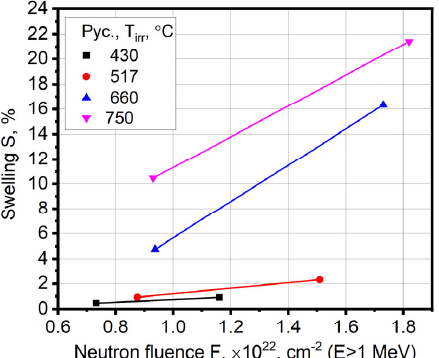
Figure 7. Dose dependence of swelling S of cast Be, reactor HFR, T irr = 430–750 °C, F = (0.73–1.82) ∙ 10 22 cm − 2 (E > 1 MeV) (pyc.—pycnometry).